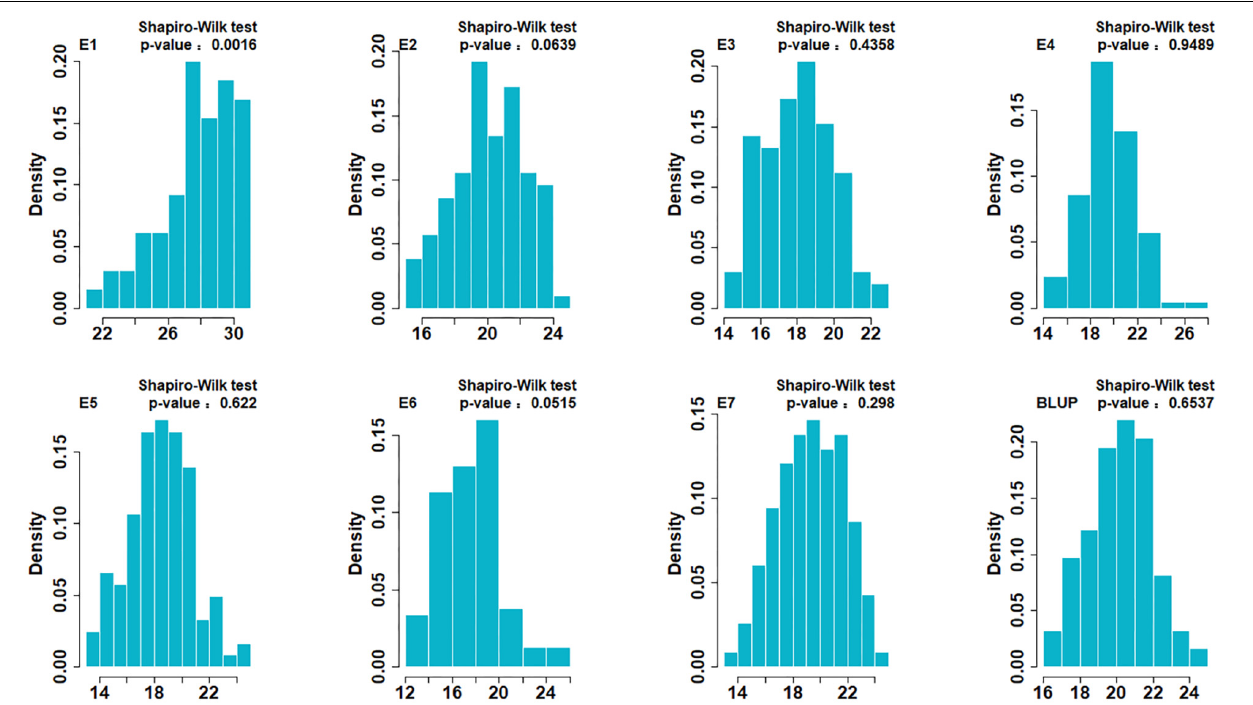
FIGURE 1 | Histograms of the ND3753/LX99 DH population for SDS-sedimentation volume (SSV) under BLUP data. The Y-axis represents the density (the ratio of frequency to group distance) of each trait and the X-axis represents the phenotypic data.